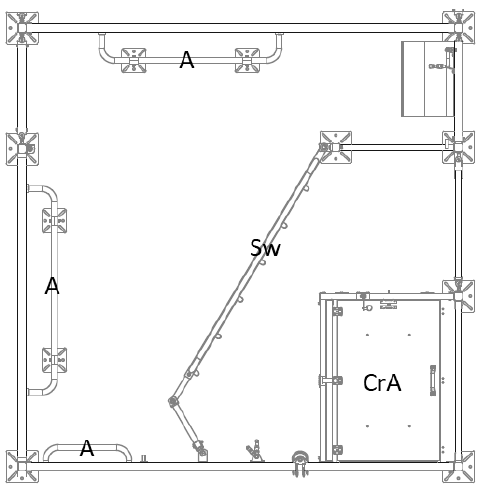
Figure 2. Single loose housing pen (LH). CrA = creep area, Sw = swing gate, A = anti-crushing bars. © Big Dutchman International GmbH, Vechta, Germany.